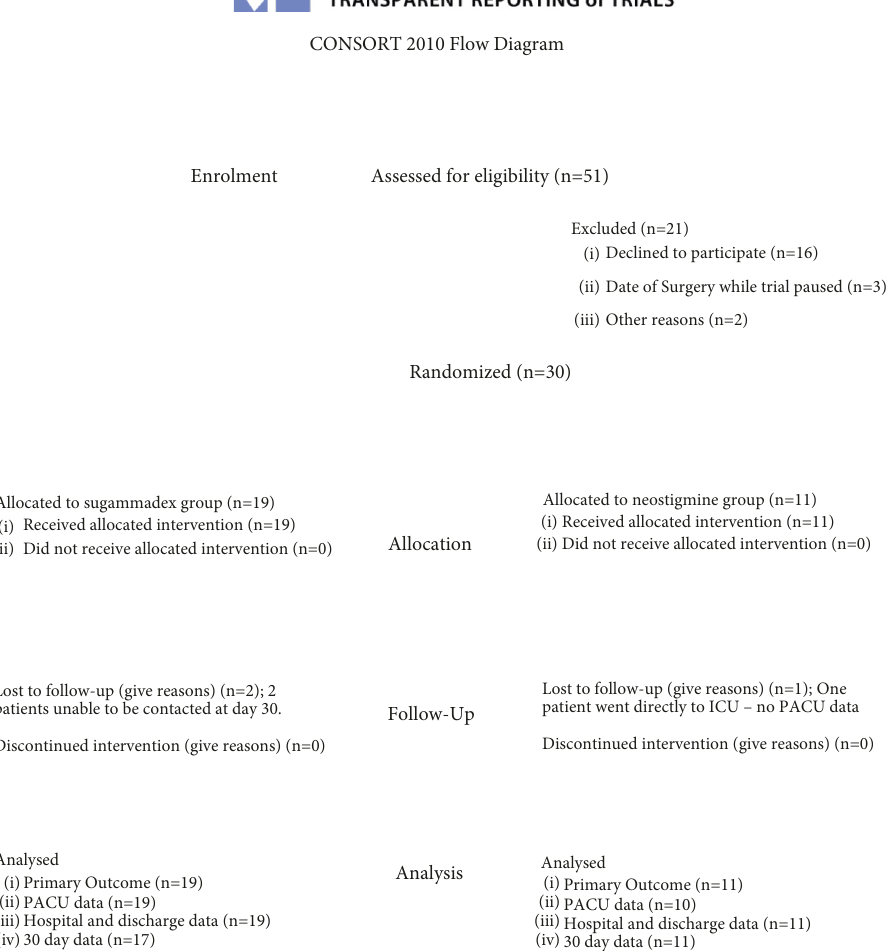
Figure 1: CONSORT flowchart for the P-PERSoN